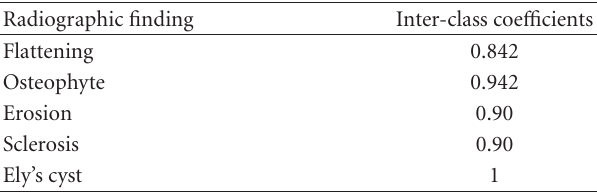
Table 9: Inter examiner